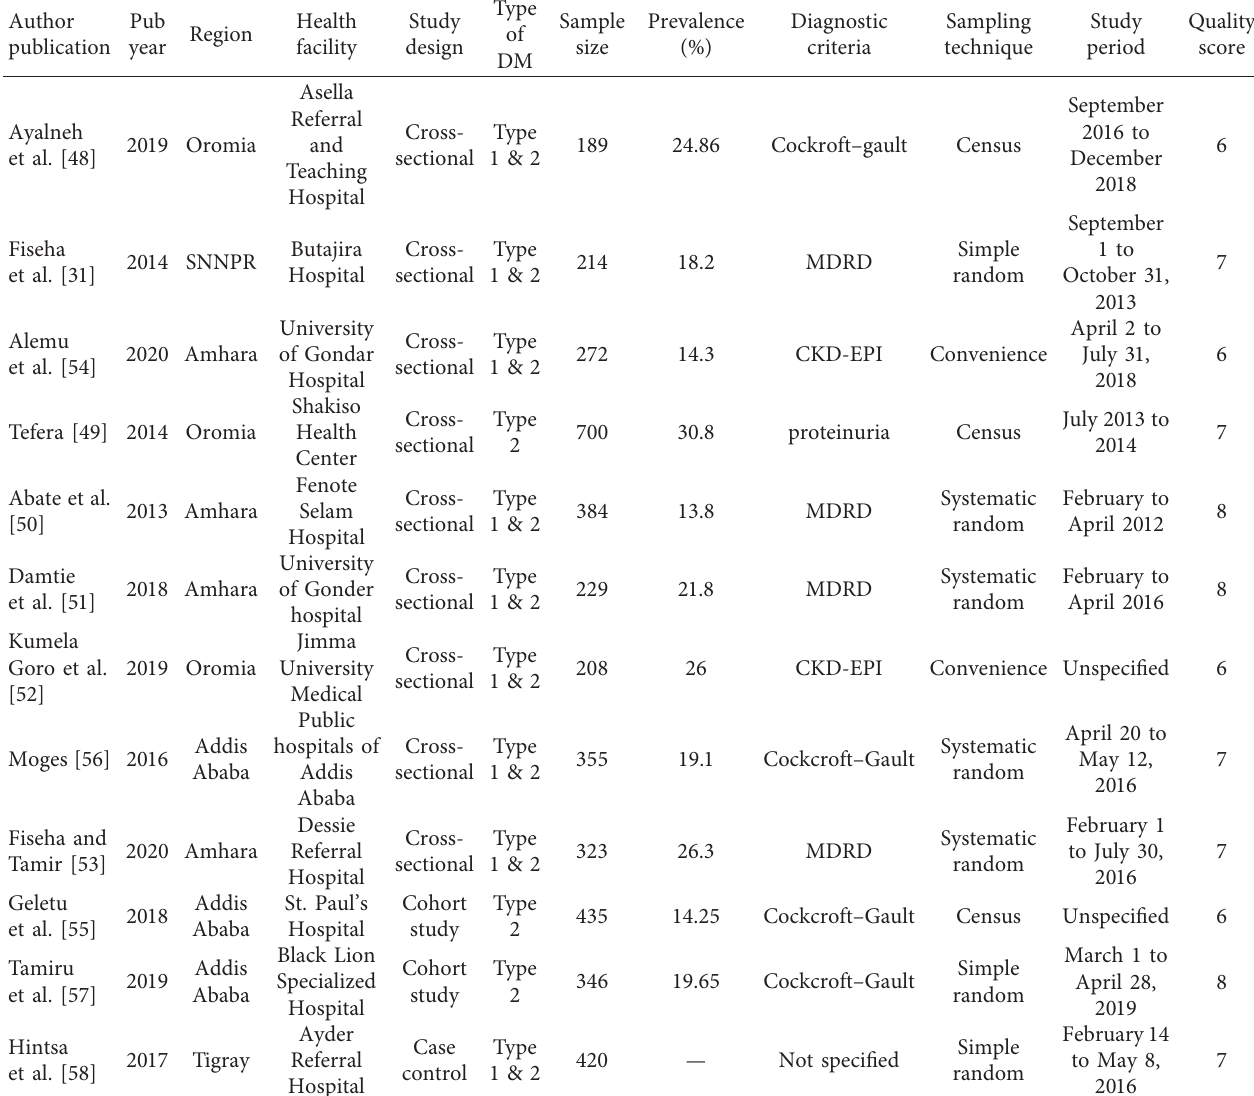
Table 2: Baseline characteristics of the included